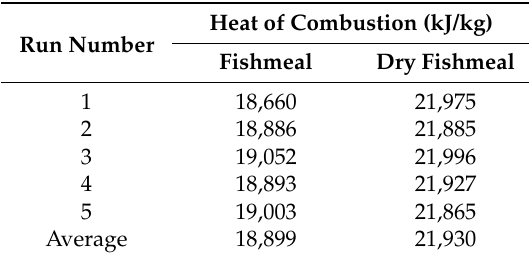
Table 7. Heats of combustion of